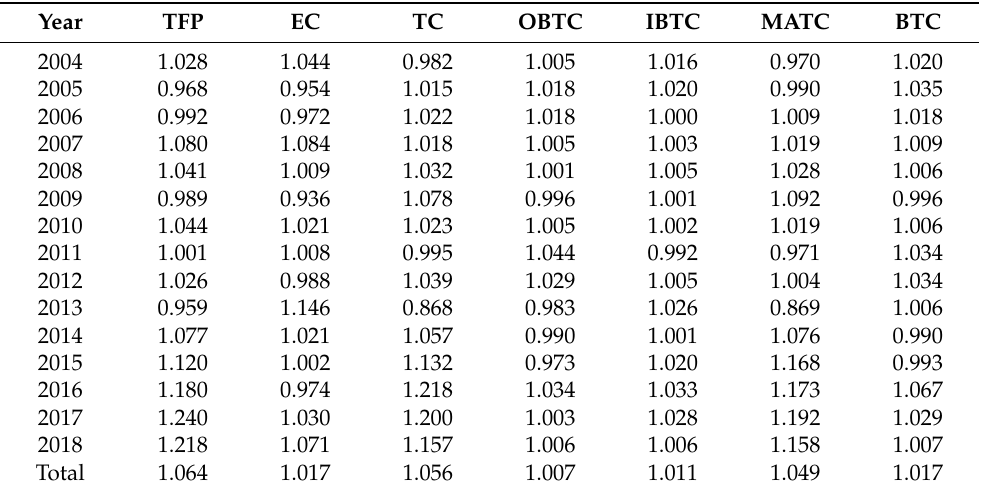
Table 4. Annual average of green total factor productivity and its decomposition term in